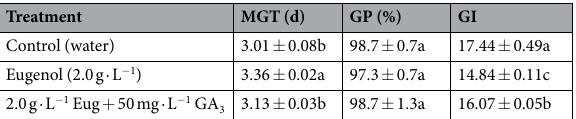
Table 3. Effects of eugenol alone and eugenol-GA 3 combined treatment on seed germination of hybrid rice Qian You 1. Each value represents the mean (n = 3); small letters following the values within each column indicated significant differences ( α = 0.05, LSD) among control and eugenol